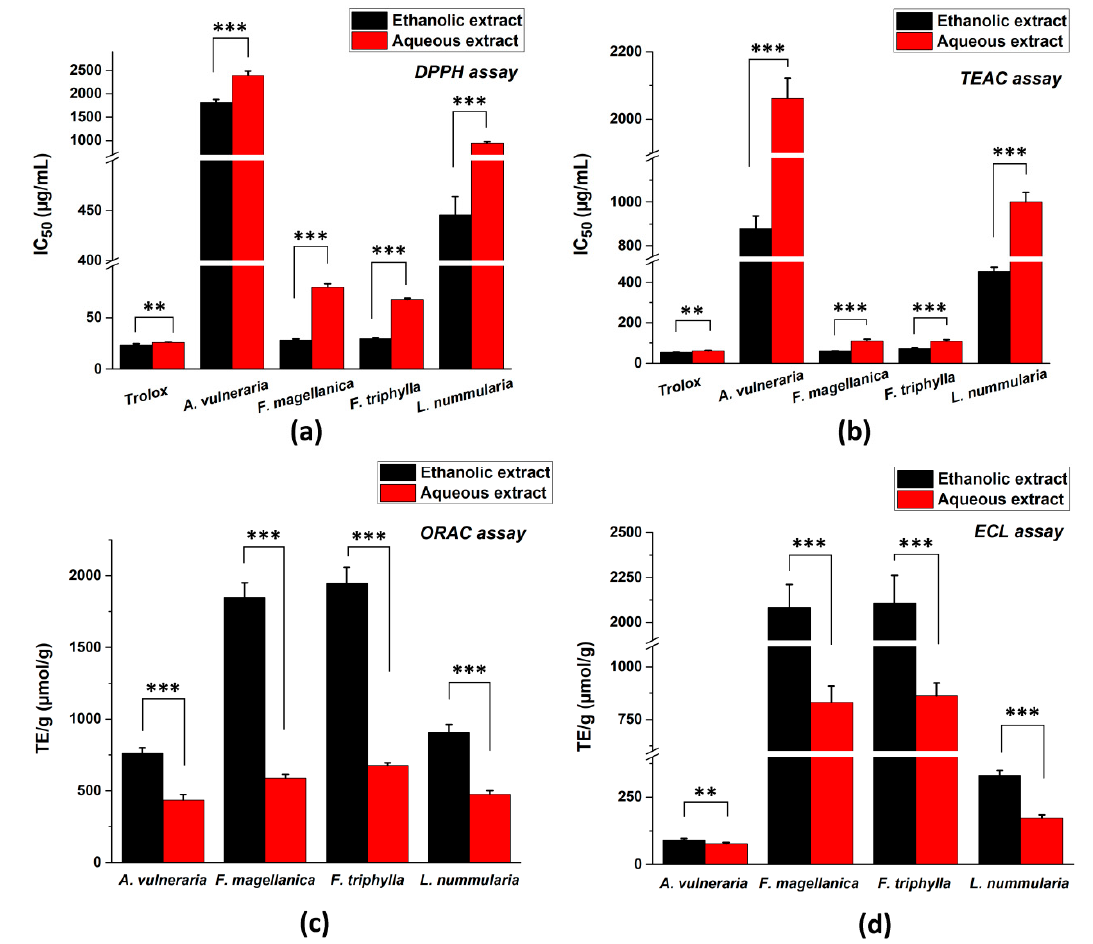
Figure 1. Total antioxidant capacity (TAC) of four selected medicinal plants measured by different spectroscopic methods: ( a ) DPPH assay; ( b ) TEAC assay; ( c ) ORAC assay and ( d ) ECL assay. IC 50 values (in µg/mL concentration at 50% inhibition) were calculated in case of DPPH and TEAC methods, while TE/g values (Trolox equivalent in µ mol referred to 1 g of initial dry material) were determined in case of ORAC and ECL tests. Mean ± SD of 5 independent experiments, each in 3 replicates. The aqueous and ethanolic extracts were compared with t-probe (** p < 0.01, *** p < 0.001).